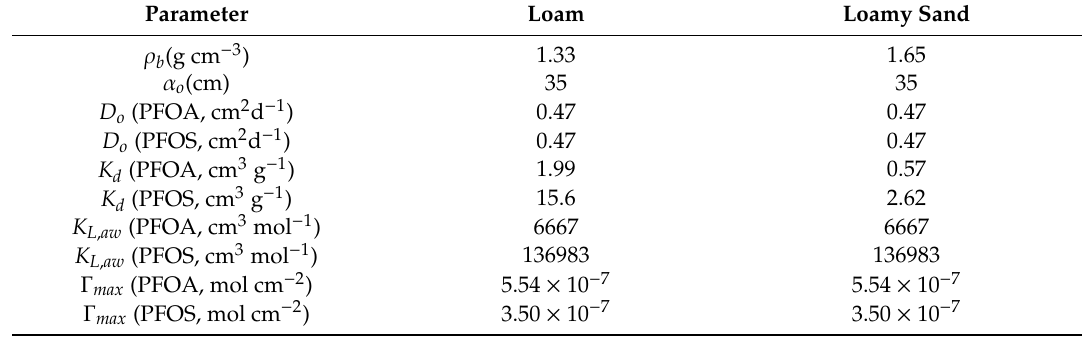
Table 3. Additional Model Parameters.